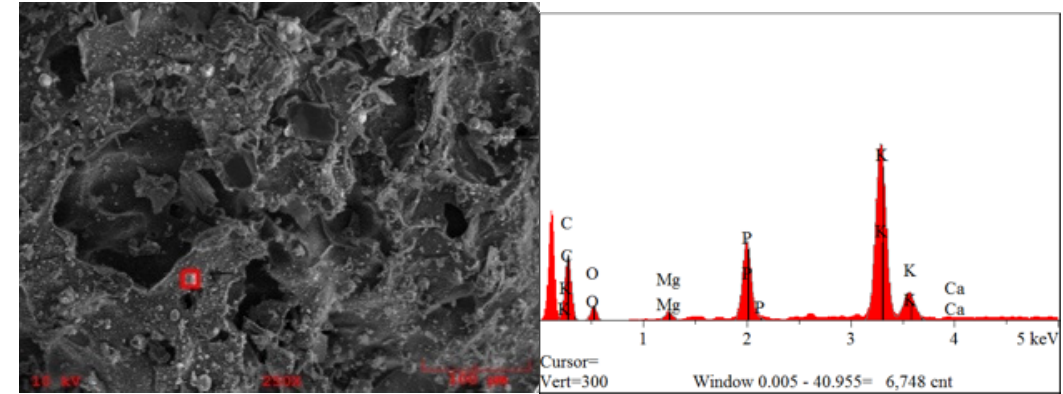
Figure 4. Surface area analysis from corn biochar - pore region (Elements from left to right K, Ca, C, Mg, P, K, Ca).